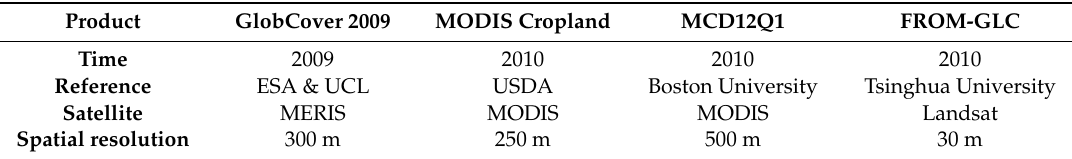
Figure 1. The remote sensing cropland products within China used in the study ( a ) GlobCover 2009; ( b ) MODIS Cropland; ( c ) MCD12Q1; ( d ) FROM-GLC. Table 1. The remote sensing cropland products used in the